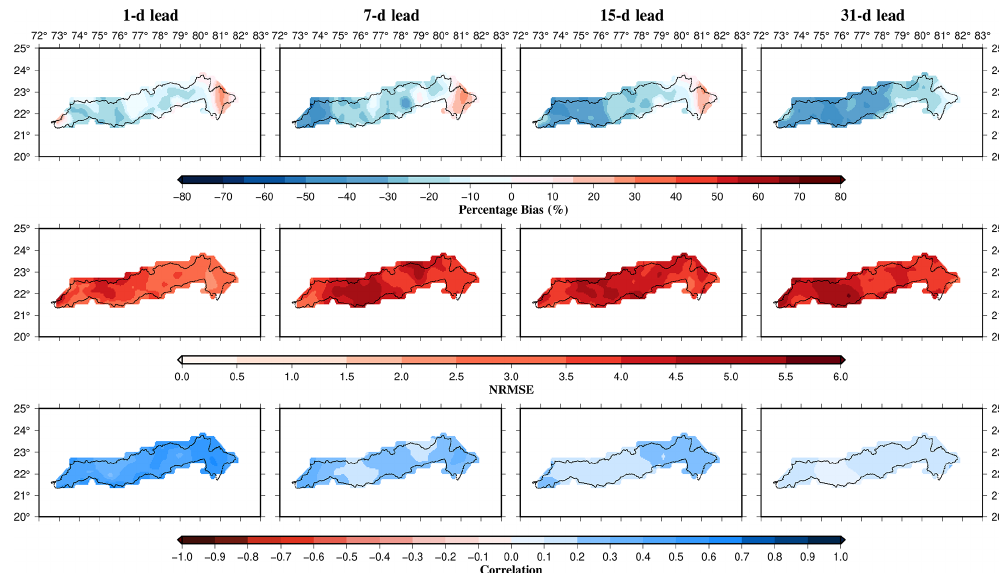
Figure 2. Evaluation of ERFS precipitation forecast against observations for the 2003–2018 period. Forecast skills were evaluated using bias, NRMSE, and correlation for each ensemble member and the median skill is presented.